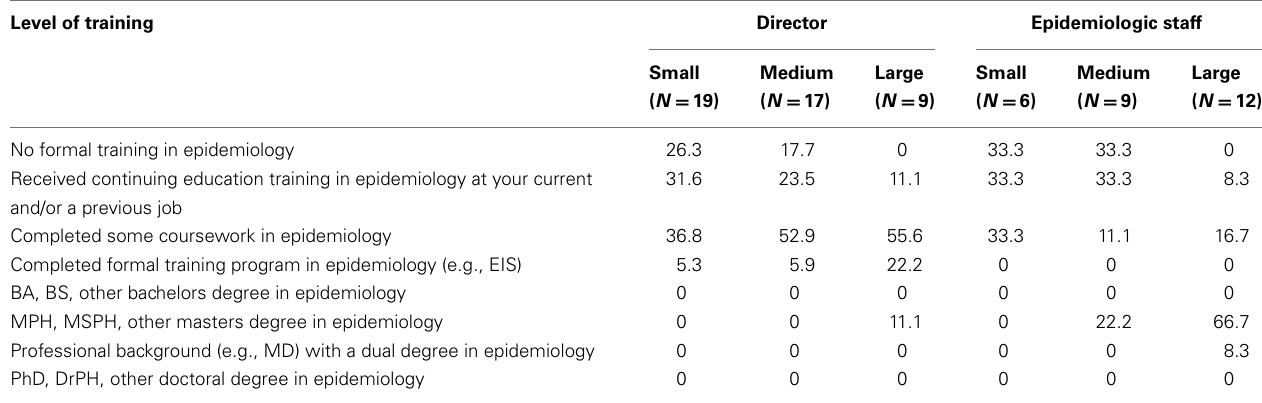
Table 3 | Highest level of training obtained in epidemiology of directors and epidemiologic staff employed at local health departments, by percentage of group that have obtained training .